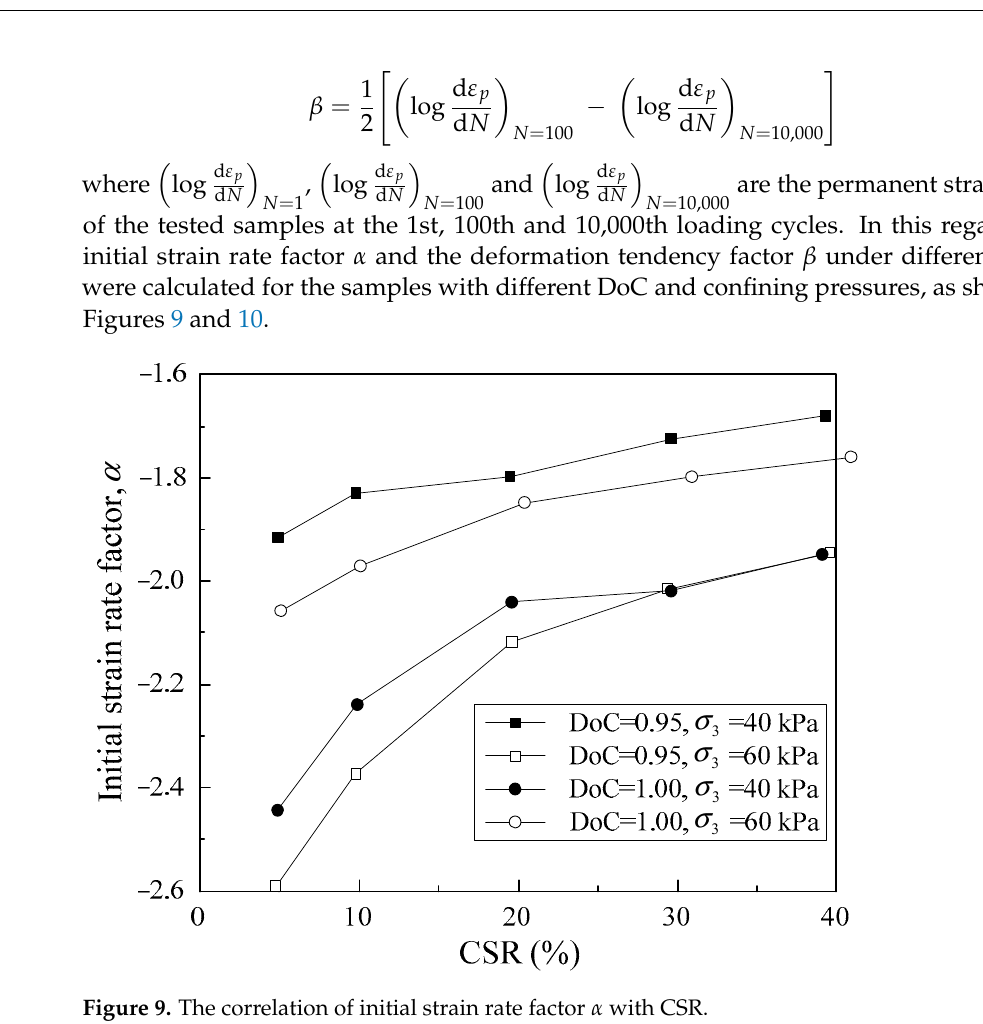
Figure 9. The correlation of initial strain rate factor α with CSR.